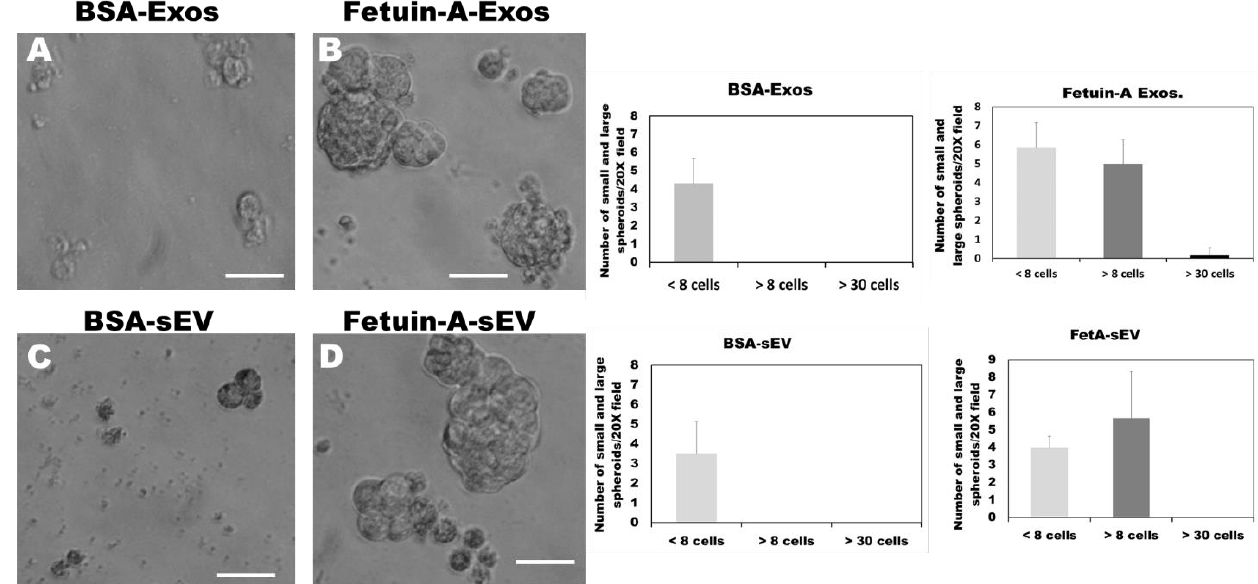
Figure 2. Extracellular vesicles isolated in the presence of fetuin-A mediate the 3-D growth of LNCaP cells. Extracellular vesicles (exosomes and ‘sEVs’) were isolated as described in Materials and Methods. Single cells (1 × 10 4 cells/well) were plated in an ultra-low attachment 24-well plate in serum-free medium containing BSA-exosomes (50 µ g/well) (panel ( A )); Fetuin-A exosomes (50 µ g/well) (panel ( B )); BSA-sEV (50 µ g/well) (panel ( C )); and Fetuin-A-sEV (50 µ g/well) (panel ( D )). The number of the different colony sizes (per 20 × field; N = 6) obtained under each condition was determined after 10 days of growth and graphed as shown. Scale bars = 50 µ m. The experiment was repeated 5 times. 2.3. Fetuin-A Sequesters Rhodamine Isothiocyanate Labeled Large Extracellular Vesicles (LEV) on the Surfaces of Cells Growing in 3-D but Internalizes These Vesicles in Adhered and Spread LNCaP Cells attached or rounded cells, we added rhodamine isothiocyanate labeled LEV (15 µ